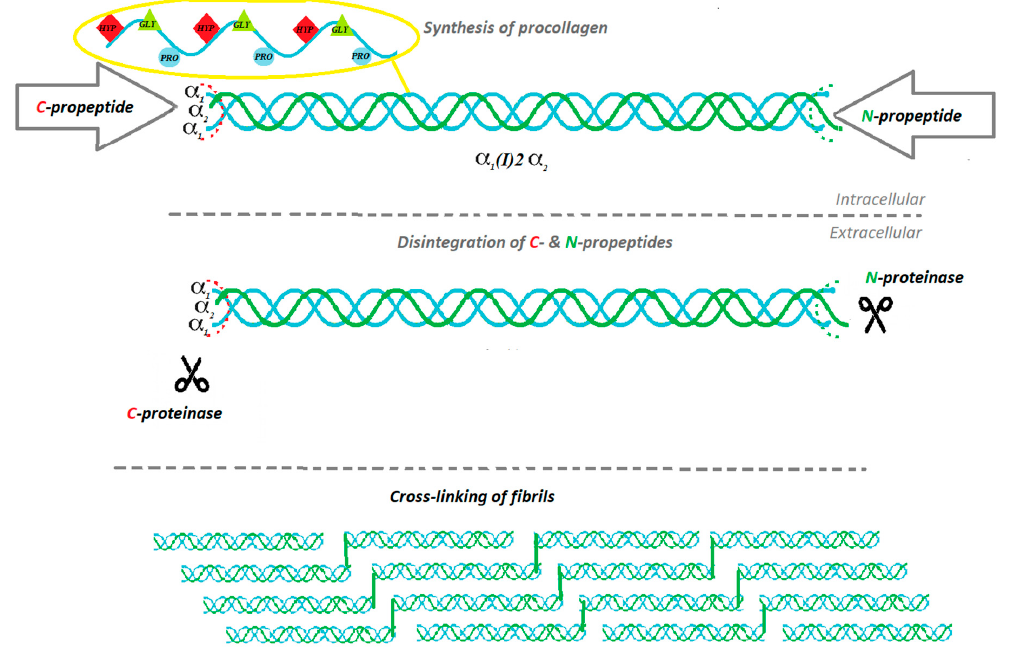
Figure 1. Biosynthesis and processing of collagen type I.